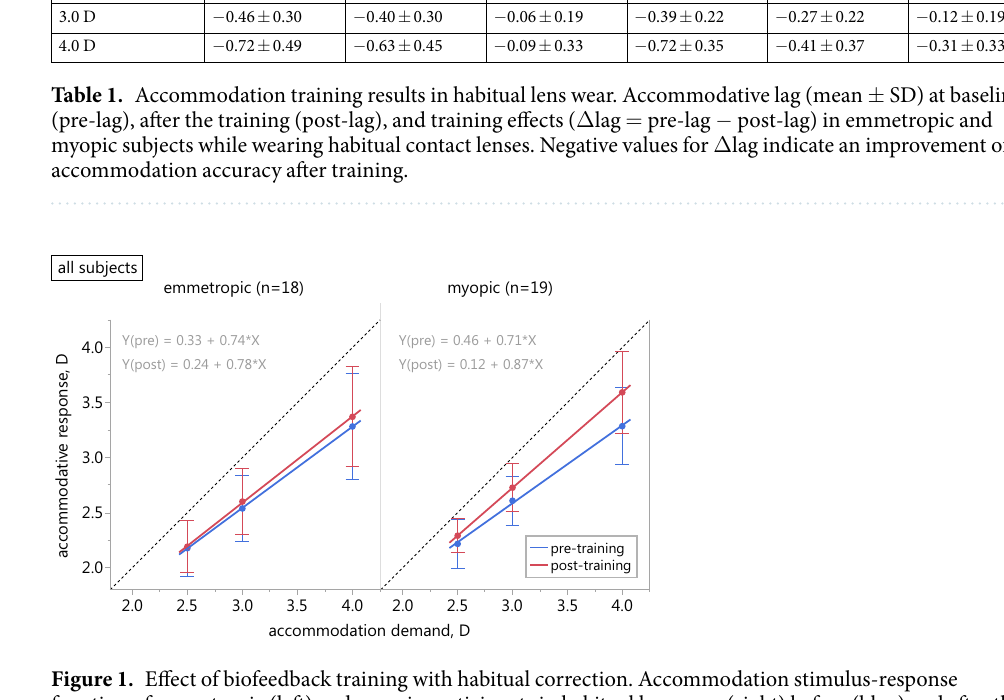
Figure 1. Effect of biofeedback training with habitual correction. Accommodation stimulus-response function of emmetropic (left) and myopic participants in habitual lens wear (right) before (blue) and after the biofeedback training (red). Error bars represent SD of the mean; the dashed line has a slope of